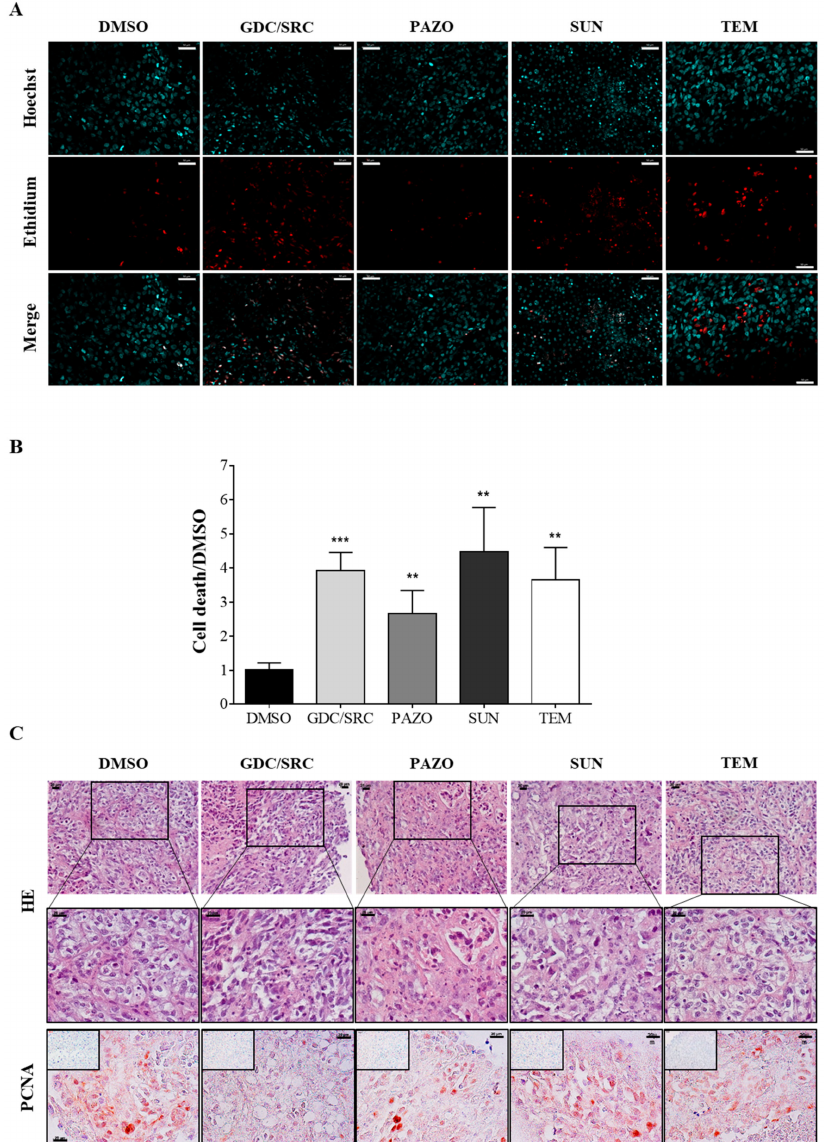
Figure 3. Treatment of slice cultures from 786-O tumor xenografts. 786-O cells were injected under the renal capsula of Balb / c nude mice. One month later, mice were euthanized, tumors were harvested and processed for tissue slice cultures. ( A ) Tissue slice cultures were treated with 10 µ M of either GDC-0941 + saracatinib (10 µ M each, GDC / SRC), pazopanib (PAZO), sunitinib (SUN), temsirolimus (TEM), or vehicle (DMSO 0.2%) for 48 h. Nuclei were stained with Hoechst 33342 and dead cells were visualized by Ethidium homodimer staining. Images were taken with an Apotome-equipped Zeiss microscope. Bar scale 50 µ m. ( B ) The intensity of Ethidium homodimer positive cells was measured in each nucleus on five independent areas of the tumor slices as described in Material and Methods. The y -axis represents the ratio of the percentage of dead cells in the di ff erent groups divided by the corresponding value in the DMSO-treated-slices. Significant di ff erences in cell death were observed between DMSO versus the GDC / SRC combination (*** p ≤ 0.001) or each drug alone (** p ≤ 0.05) using a Mann–Whitney test. ( C ) Tumor slices were treated as described in A, then fixed and embedded in para ffi n. Fixed tissue slices were stained with Hematoxylin-Eosin (HE). Representative pictures of treated slices are shown at two magnifications (lower magnifications, upper images and higher magnifications, middle images). Tumor slices were also stained with the anti-PCNA antibody to visualize cell proliferation (lower panel). Negative controls (no primary antibody) are shown in the insets. Scale bars 20 µ